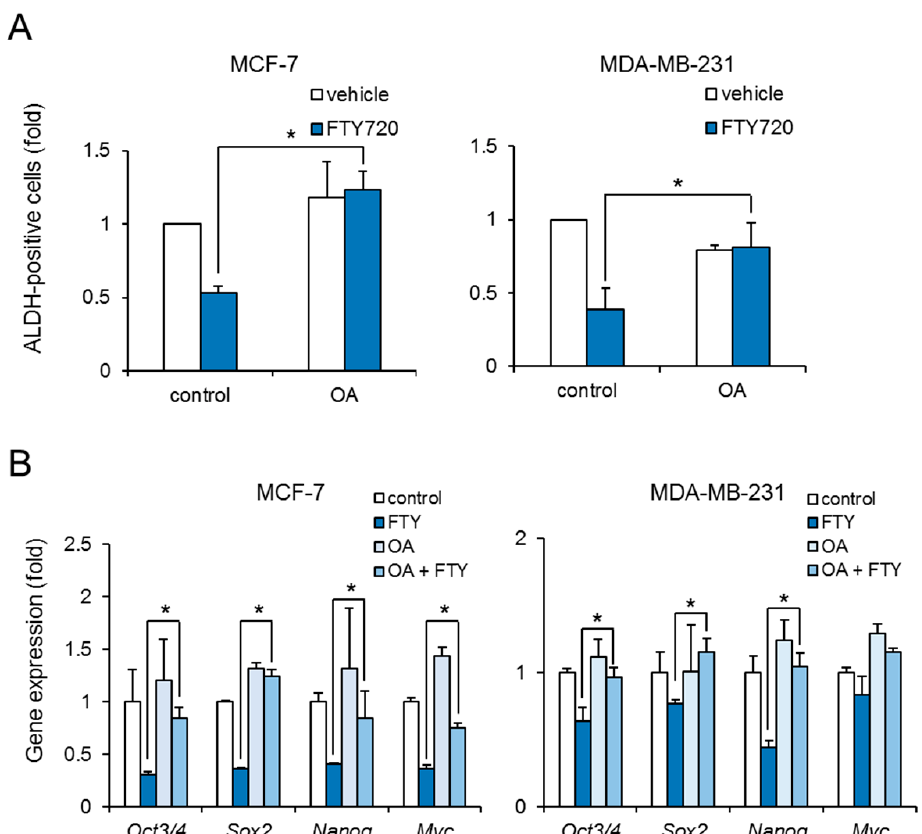
Figure 4. Effect of PP2A inhibitor on FTY720-induced negative regulation in breast CSCs. ( A ) After treatment with FTY720 (3 µ M) and/or OA (30 nM) for 3 days, the ALDH-positive cells of MCF-7 cells ( left ) and MDA-MB-231 cells ( right ) were assessed using the ALDEFLUOR kit and flow cytometry. ( B ) After treatment with FTY720 (3 µ M) and/or OA (30 nM) for 48 h, expression levels of stem cell marker genes in MCF-7 cells ( left ) and MDA-MB-231 cells ( right ) were measured by real-time RT-PCR. Data represent mean ± s.d. ( n = 3). * p < 0.05.